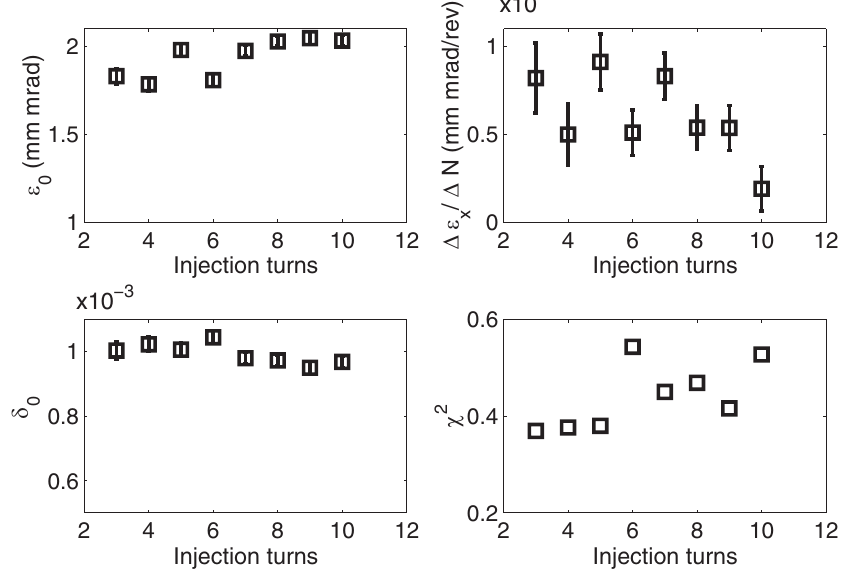
(cid:5) a (cid:3) (cid:3) (cid:4) . Top right: the horizontal (cid:6) =(cid:3) p x 0 0 0 0 0 (cid:5) (cid:3)(cid:3)(cid:3)(cid:3)(cid:3) b =D at the 3001 revolution. Bottom right: the (cid:5) 0 0